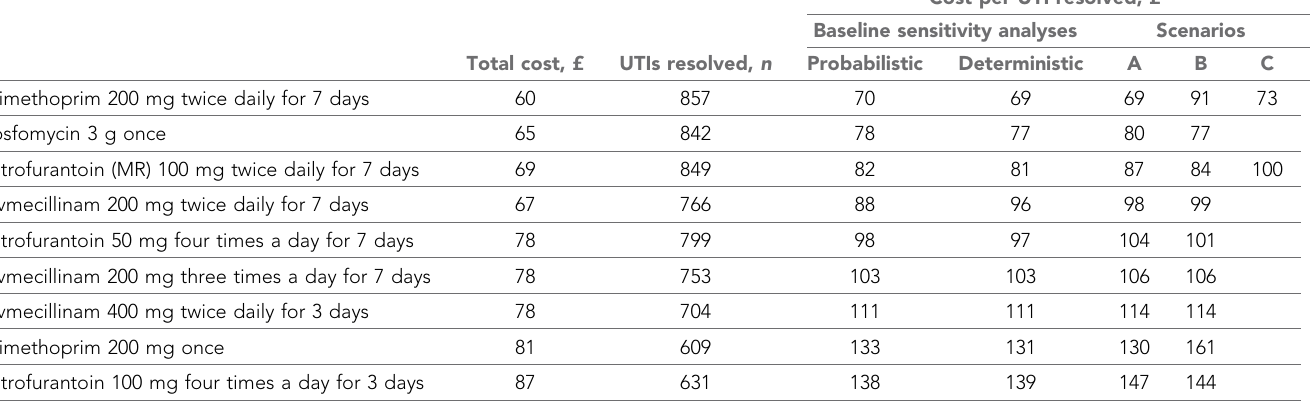
Table 3. Probabilistic costs, health outcomes, and cost per UTI resolved per treatment regimen modelled